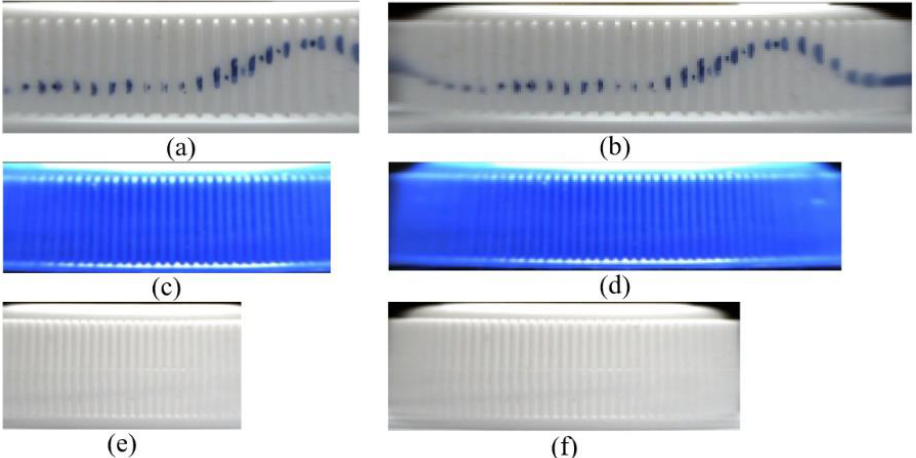
Figure 14. Results after the cylindrical back-projection: ( a , c , e ) Results after the cylindrical back- projection on the best observation regions of cameras of the three samples; ( b , d , f ) Results after the cylindrical back-projection on the image of the full side of the caps of the three samples.